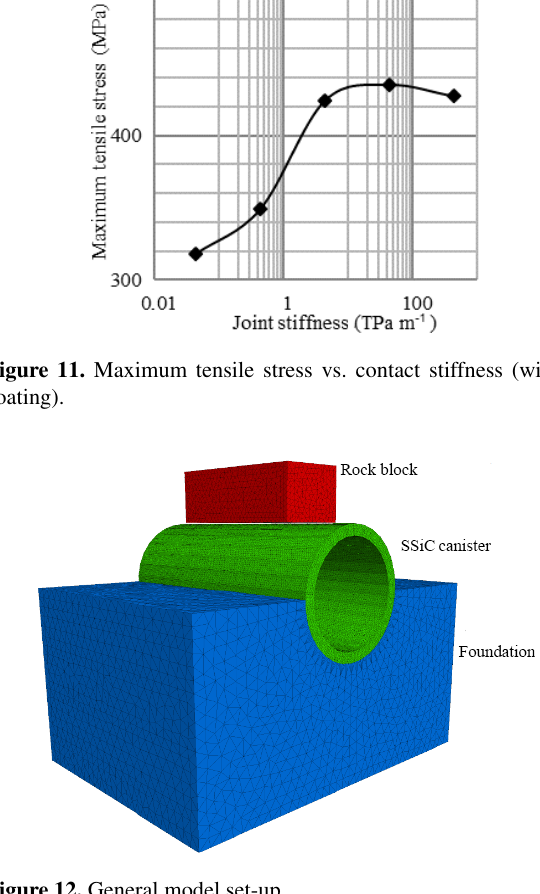
Figure 12. General model